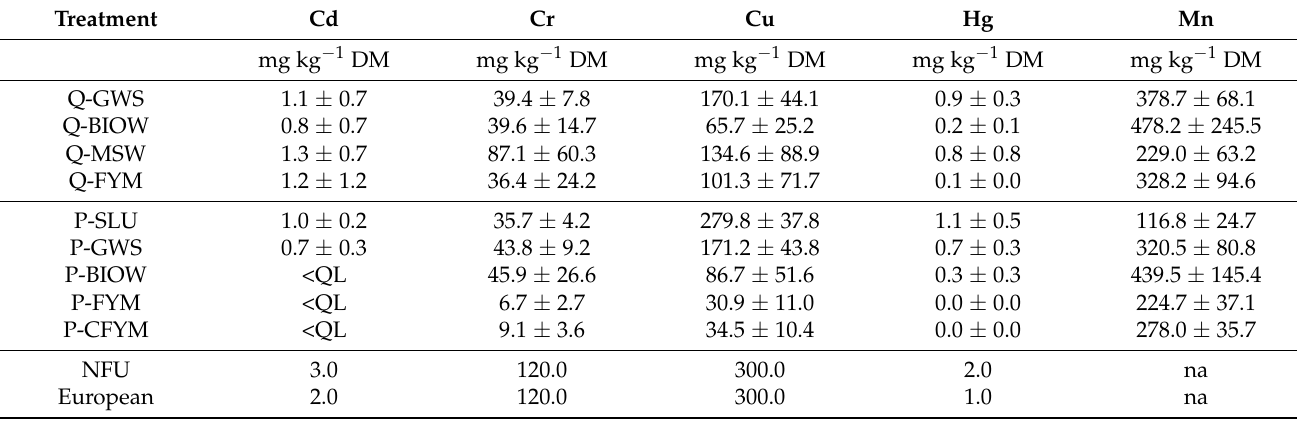
Table 2. Trace element concentrations (mg kg − 1 DM; DM for dry matter) in the organic waste products, as compared to French (NFU) and recent European regulations levels [10,11,56,57], with the following data presented: average values for the period 1998–2013 ± standard deviations ( n = 8 for QualiAgro, n = 7 for PROspective). See Figures 1 and 2 for treatments signification. <quantification limit (QL): at least half of values were lower than the quantification limit; na for not